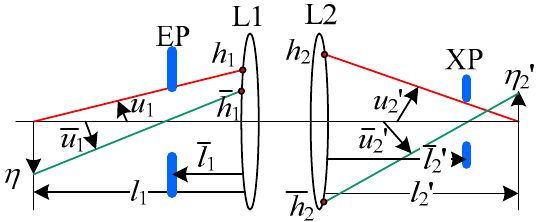
Figure 1. A two-lens element optical system.